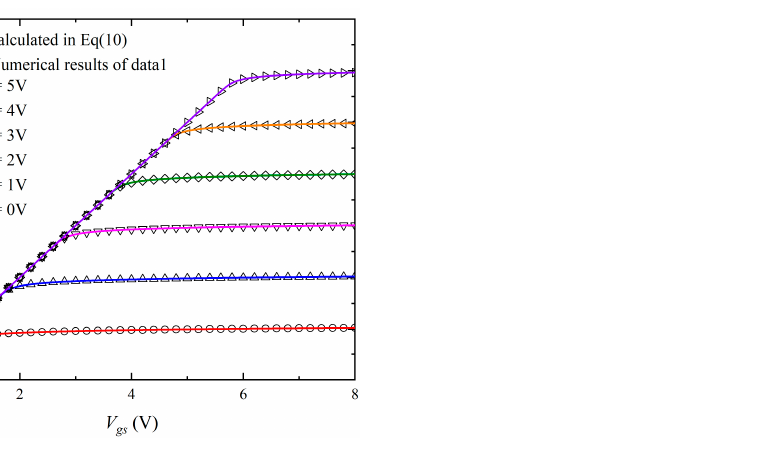
Figure 8. Comparisons of surface potential results between our model, regional approach and numerical results using data1 for different V ch .